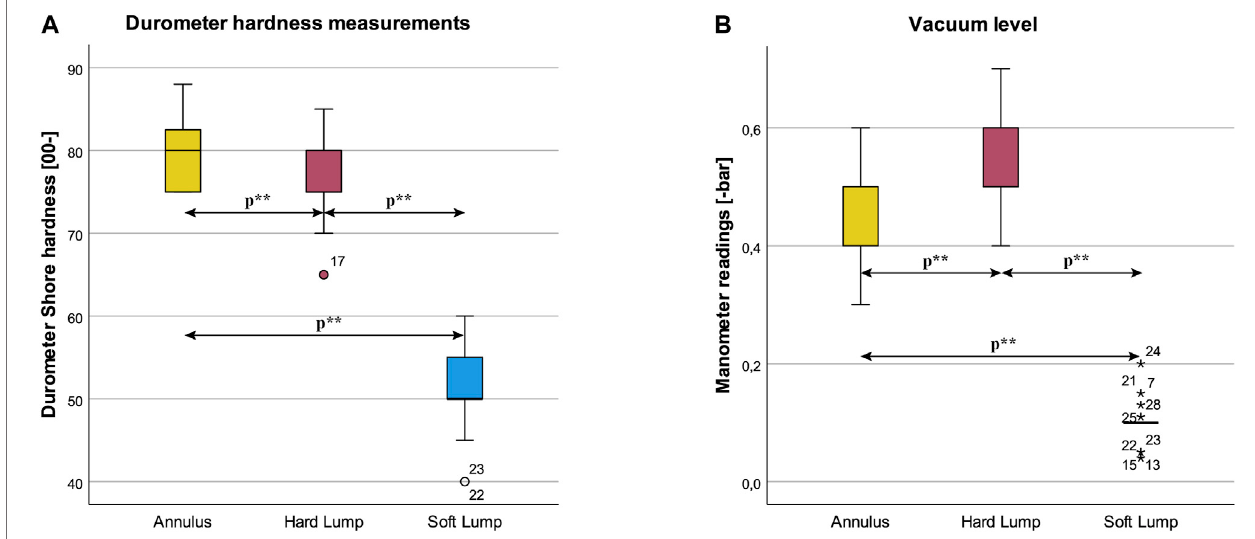
FIGURE13| Boxplotsof (A) Durometerhardnessmeasurementsand (B) vacuumlevelforthethreelumpconditions.Statisticallysigni fi cantdifferencesat p < 0.05 are indicated by p **.